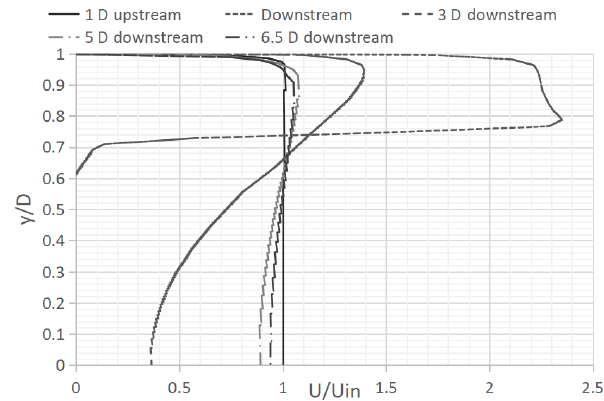
Figure 20. Velocity profiles at different axial positions, S-G cone.